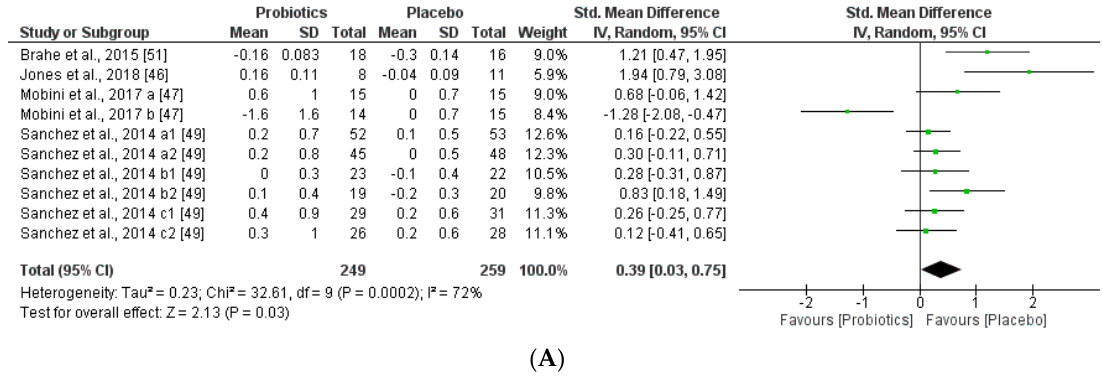
Figure 9. ( A ) Effect of probiotics on total cholesterol in CT. ( B ) Effect of probiotics on HDL-Cholesterol in CT. ( C ) Effect of probiotics on LDL-Cholesterol in clinical trials. ( D ) Effect of probiotics on TAG in clinical trials.